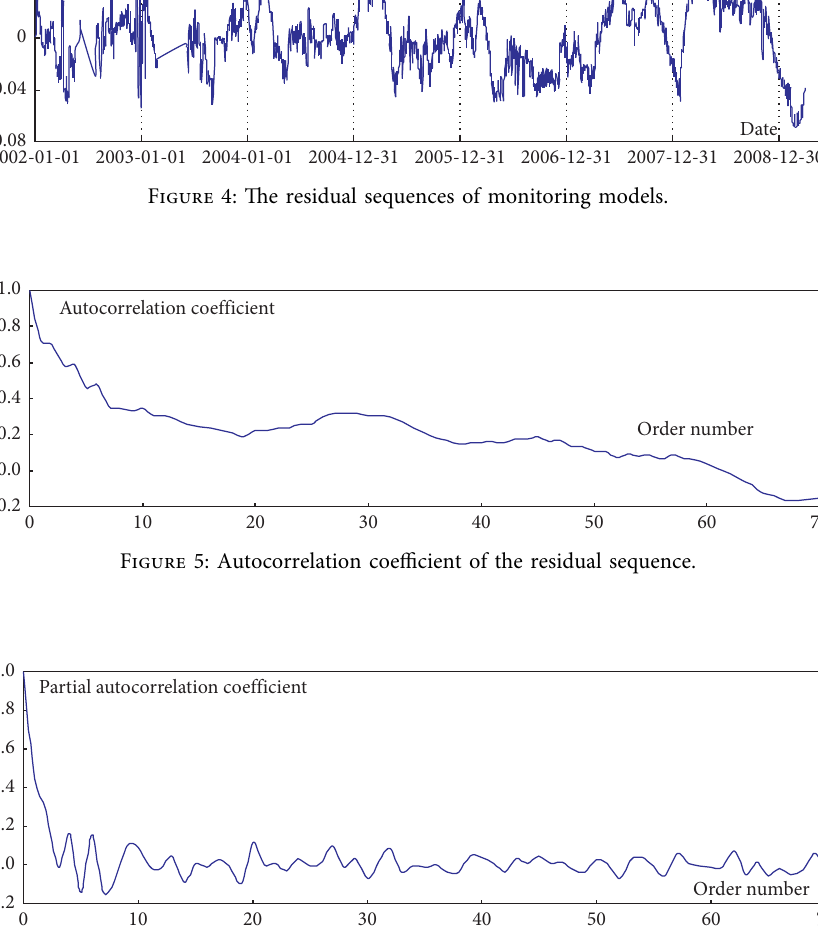
Figure 6: Partial autocorrelation coefficient of the residual